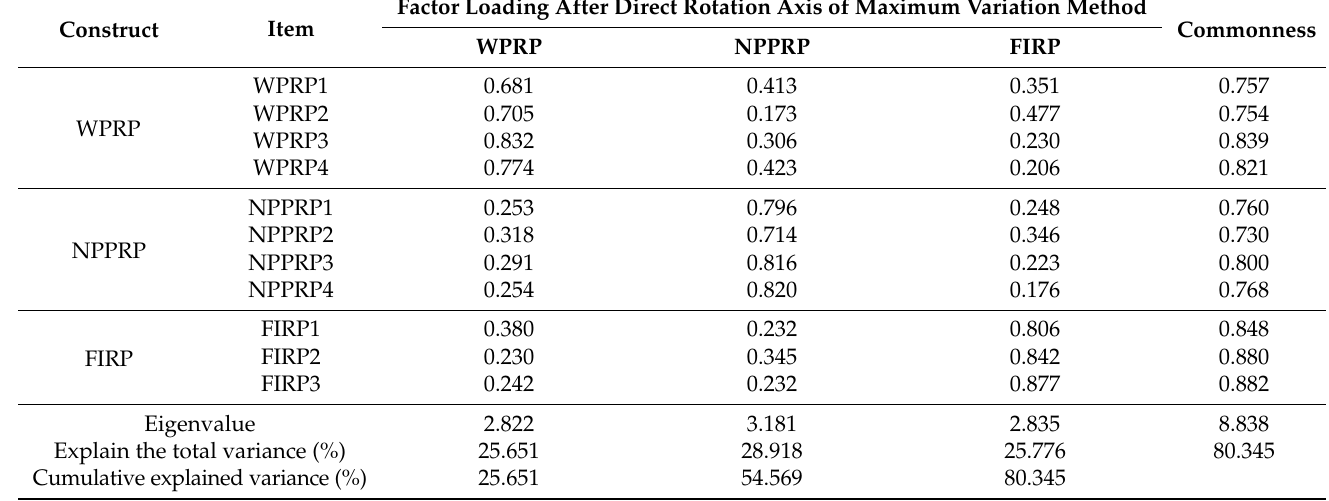
Table A3. Exploratory factor analysis of the pre-survey perceived risk scale.